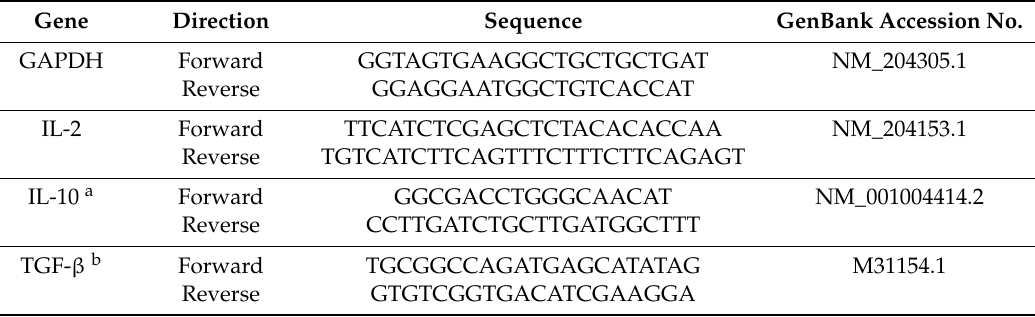
Table 1. Sequences of the primers used in